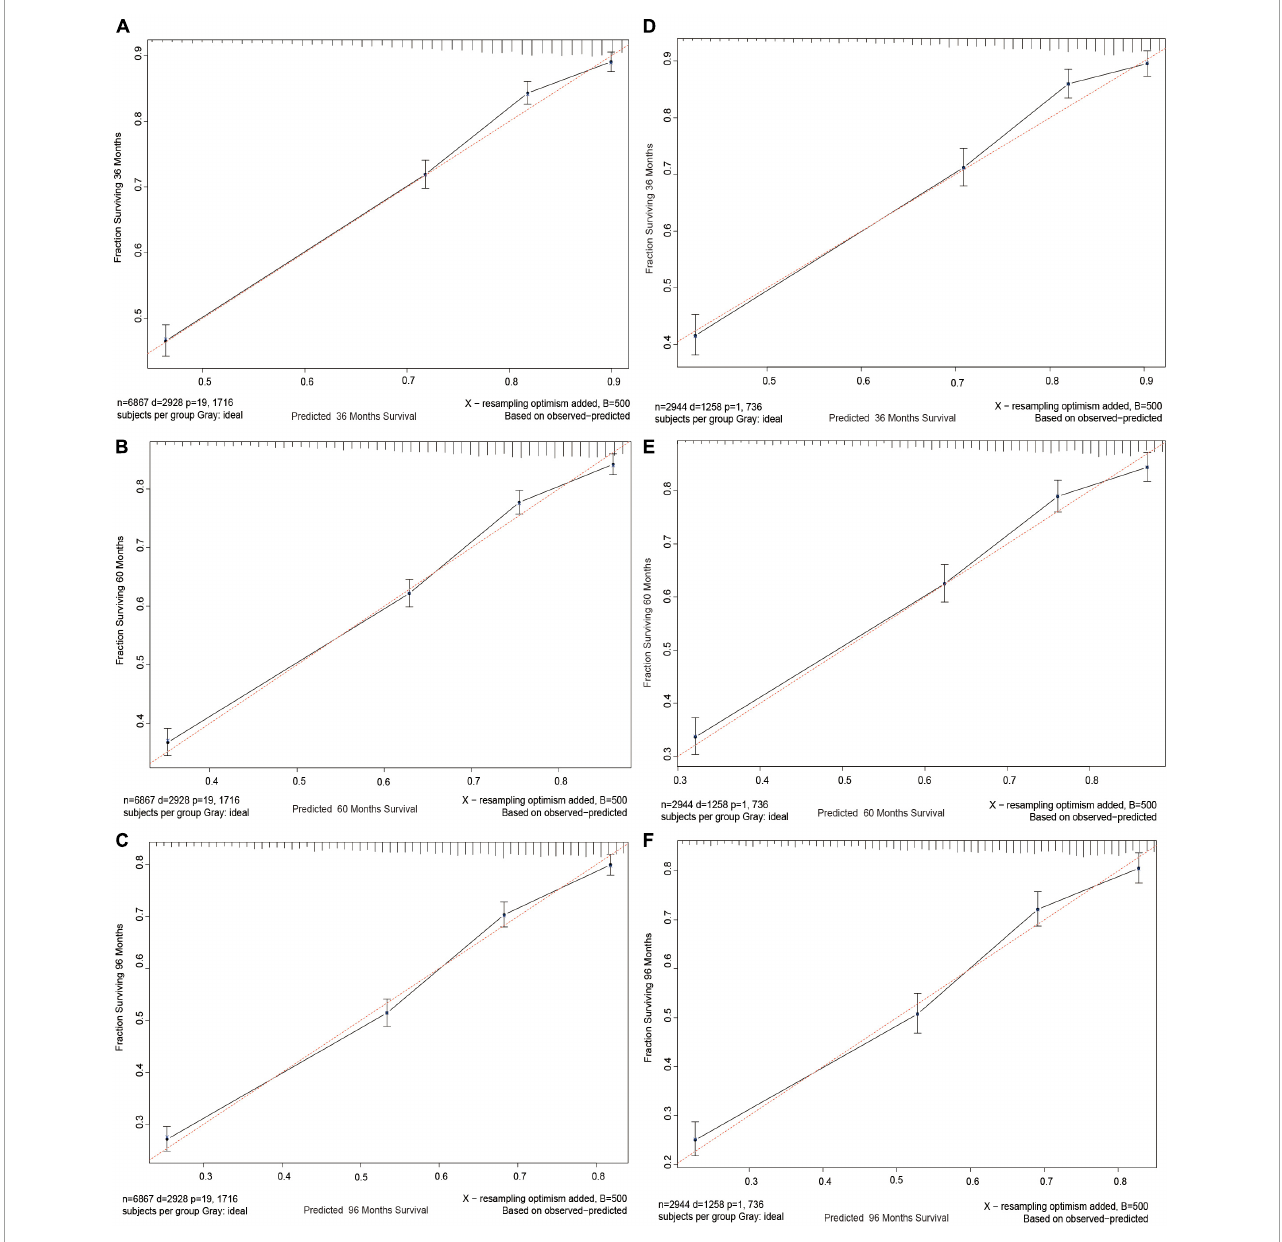
FIGURE4 Calibration curves. Calibration curves for 3-, 5-, and 8-years CSS probability depict the calibration of each model in terms of the agreement between the predicted probabilities and observed outcomes of the training cohort (A–C) and validation cohort (D–F) .